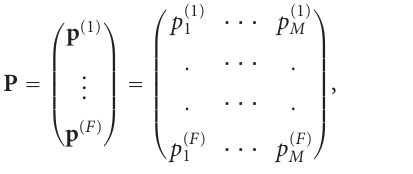
set of channel probabilities p throughout the execution of Alert. Though this results in a simpler implementation,